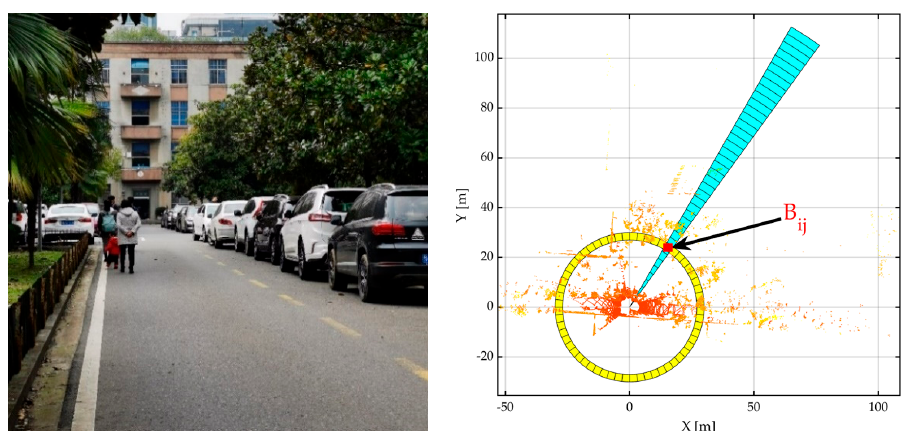
( a ) Camera view and bin division of the same place. The yellow and cyan area in the right image indicate sectors and rings, respectively. The intersection of sectors and rings is a bin, in red.